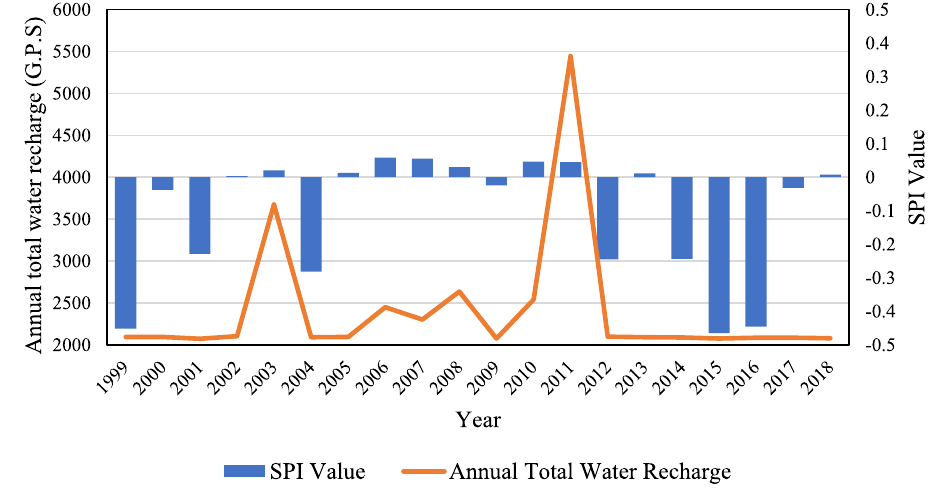
Fig. 20 Comparison of climate trend analysis and groundwater